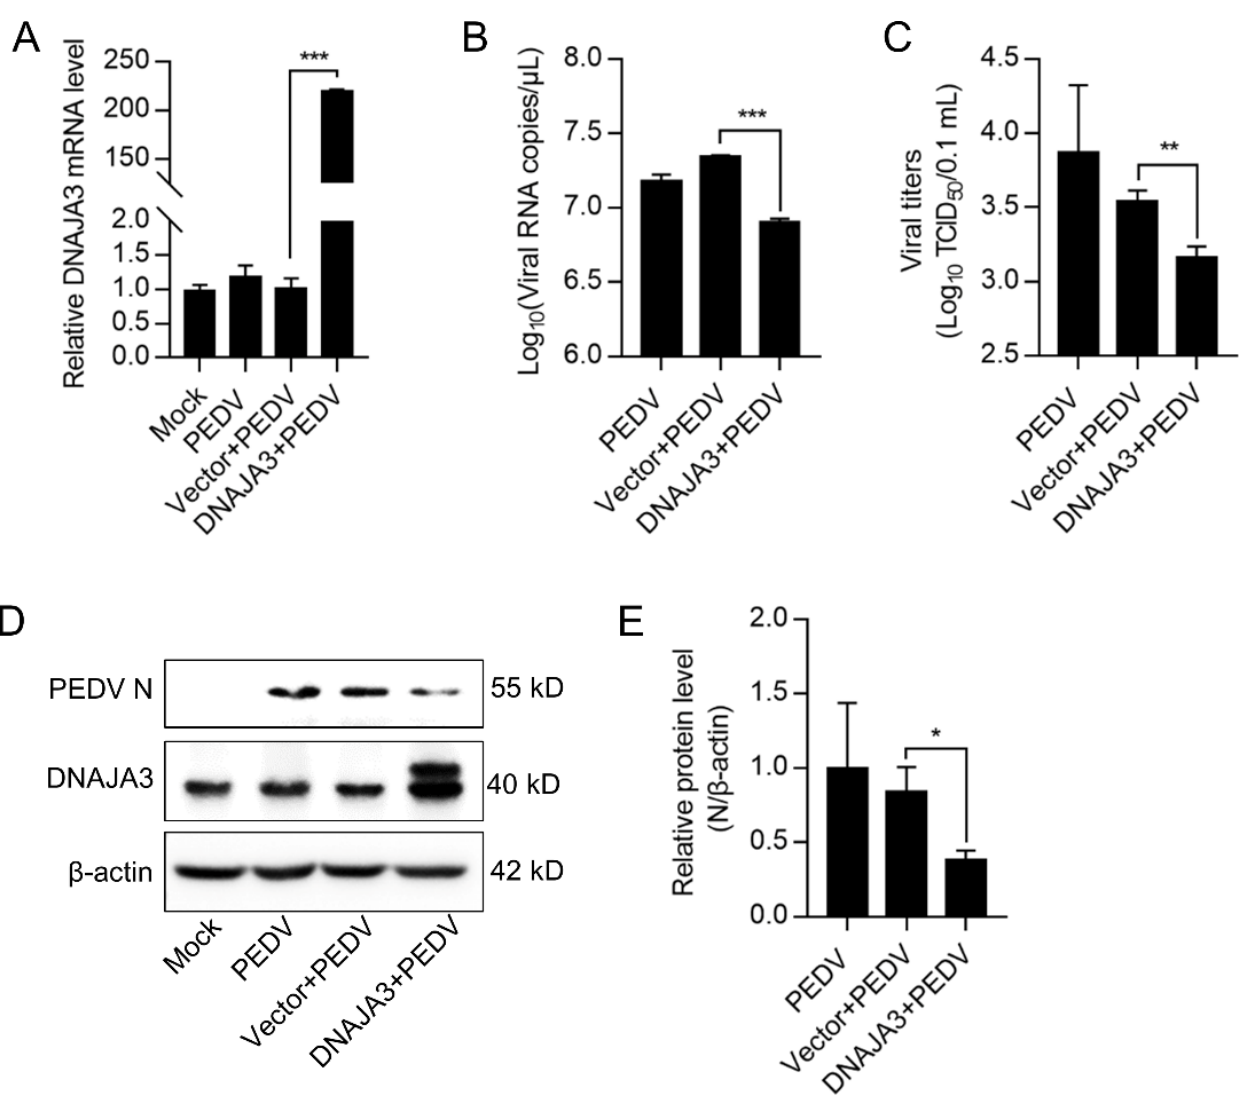
Figure 4. Transient expression of DNAJA3 inhibited PEDV replication. pCMV-DNAJA3 (DNAJA3) or pCMV-Flag (Vector) were transfected into IPEC-J2 cells for 24 h, respectively. Then the cells were infected with PEDV (1.0 MOI) for 24 h. ( A ): Relative DNAJA3 mRNA. ( B ): Viral genome copies. ( C ): PEDV titers (TCID50) in the supernatant. ( D ): Protein levels of DNAJA3 and PEDV-N by Western blotting. ( E ): Ratios of N protein to β -actin of panel D. The results were shown as means ± SD of three independent experiments; *, p < 0.05; **, p < 0.01; ***, p < 0.001.